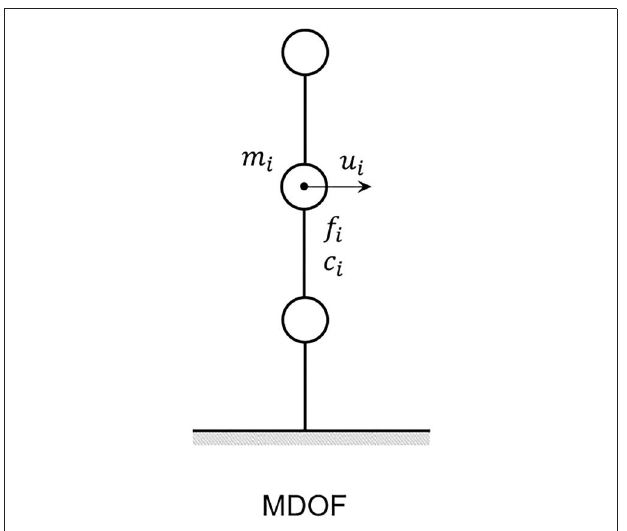
FIGURE 3 | Multi-story damped bilinear hysteretic MDOF shear building model.